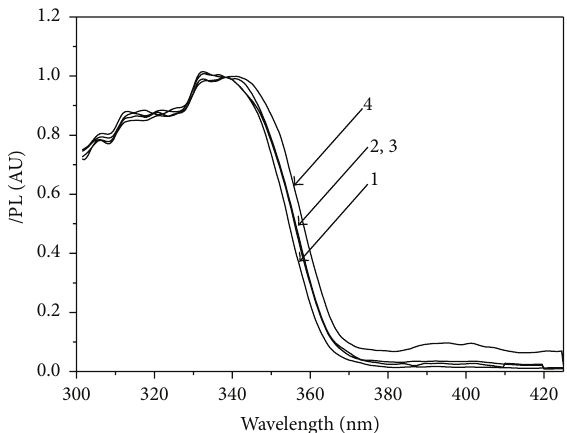
Figure 8: Normalized luminescence excitation spectra of the colloidal solutions of ZnO nanoparticles without SiO 2 (1) and in the presence of 0.25 g (2), 0.625 g (3), and 1.25g of silica (4) in 10mL of = 540 nm. zinc oxide solution. [ZnO] = 2 × 10 −2 mol/L; 𝜆 registration